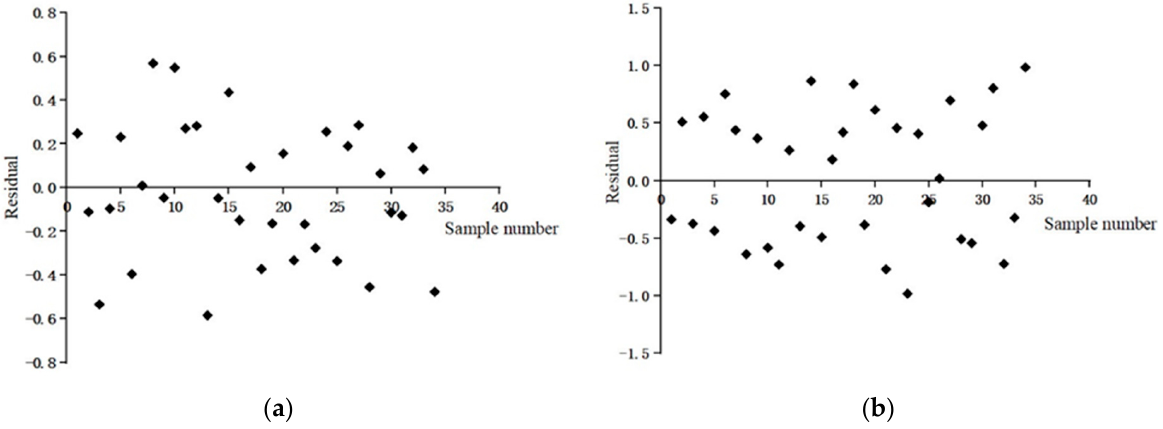
Figure 10. ( a ) Residual distribution map of the photosynthetic rate; ( b ) residual distribution map of the predicted photosynthetic rates.